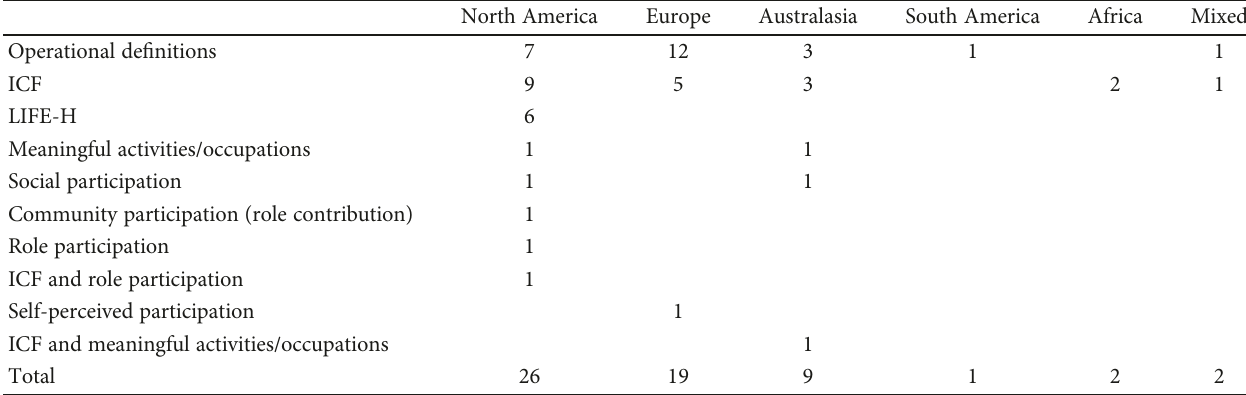
Table 7: De fi nitions of participation relative to the proportion of studies from each continent in this review on longitudinal participation outcomes after